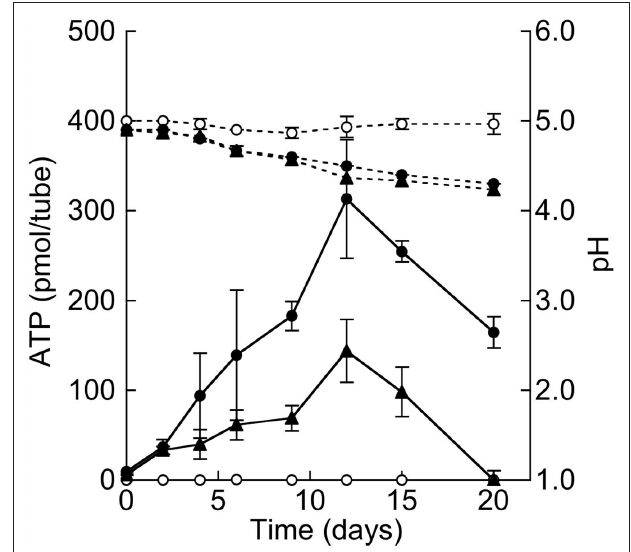
FiguRe 4 | growth of strain THi503 in WS5 medium with S 0 as the sole energy source. Growth of strain THI503 was assessed based on ATP of the culture in a 225-mL conical tube containing 50 mL culture. Error bars indicate SD, n = 3. Symbols: solid line, ATP, dashed line, medium pH, filled circles , + THI503 + 10 g S 0 L − 1 ; triangles , + THI503 – S 0 (final concentration of S 0 was 1 g L − 1 due to the carry-over from pre-culture); empty circles , − THI503 + 10 g S 0 L − 1 .